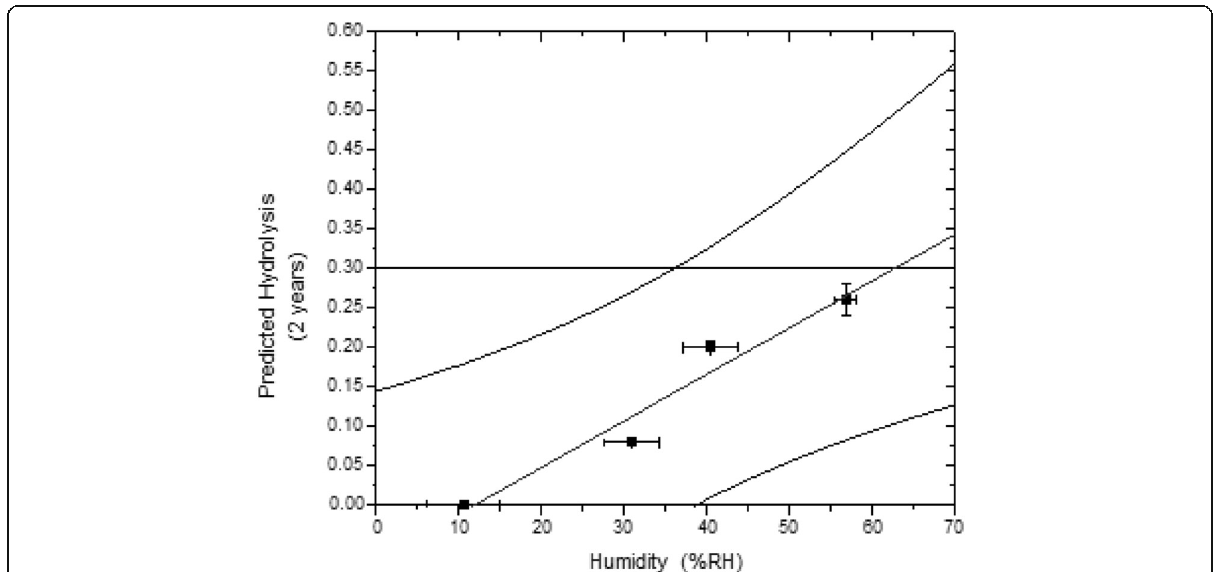
Fig. 1 Predicted Hydrolysis as a Function of Humidity at 25 °C. The Regression Line and the 95% Confidence Interval are Presented. The Proposed Specification Limit for the Hydrolysis Product is